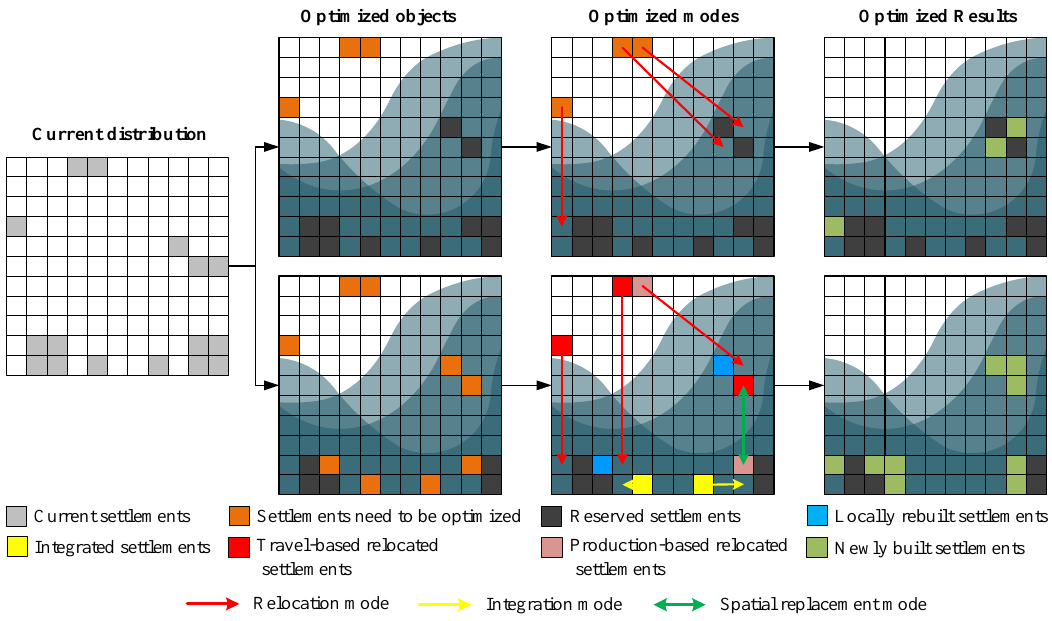
Figure 6. Conceptual model of rural settlement reconstruction.